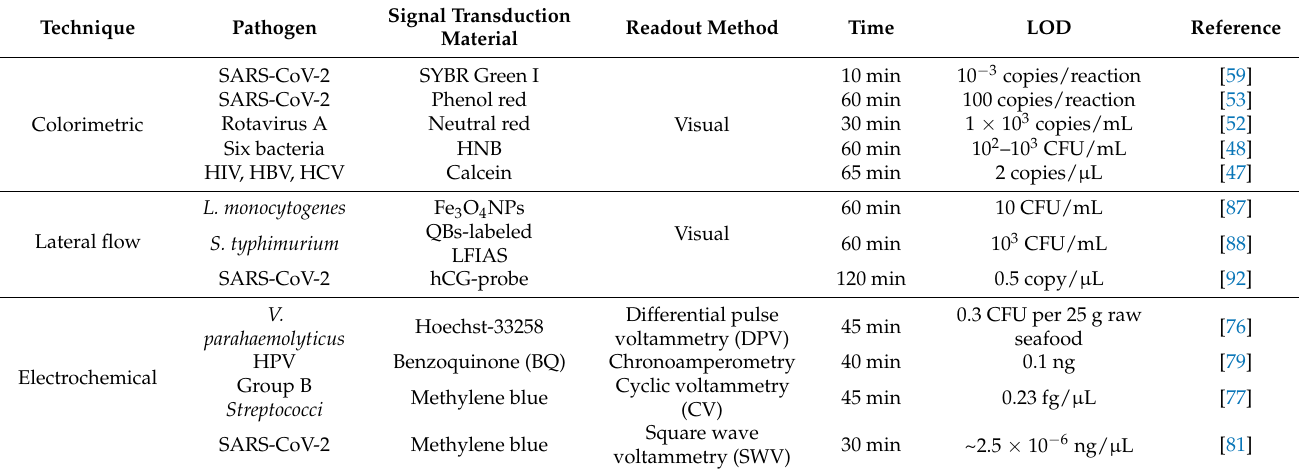
Table 1. Comparisons of end-point detection methods of LAMP